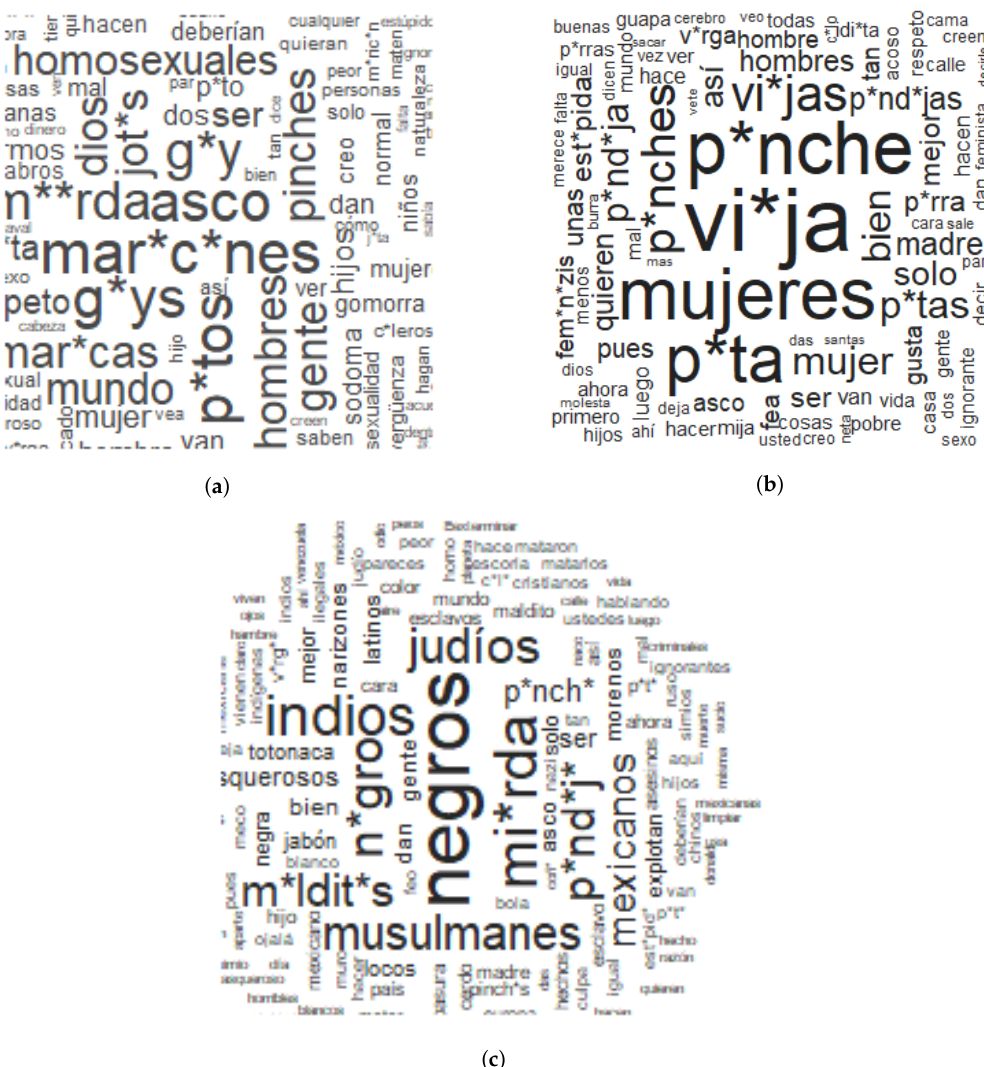
Figure 5. Word clouds for each cyber-aggression case. ( a ) Violence based on sexual orientation (VS). ( b ) Violence against women (VM). ( c ) Racism (R).